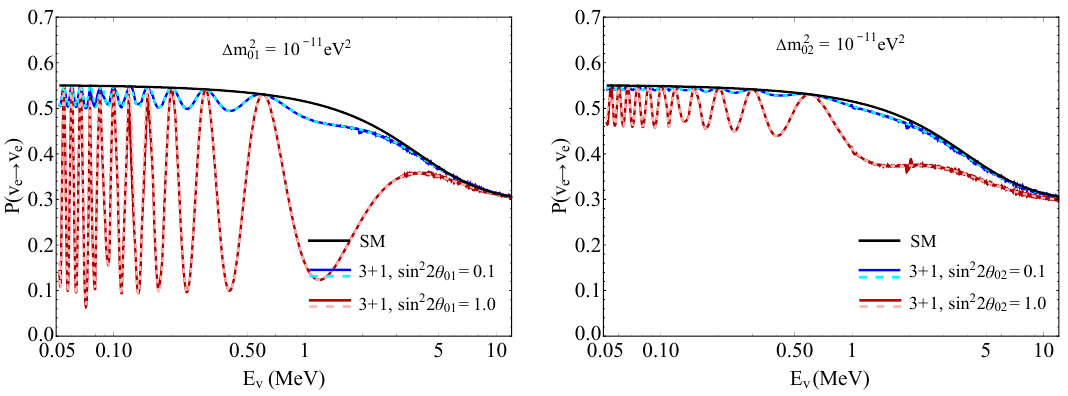
(∆ m 2 ) is set to be 01 02